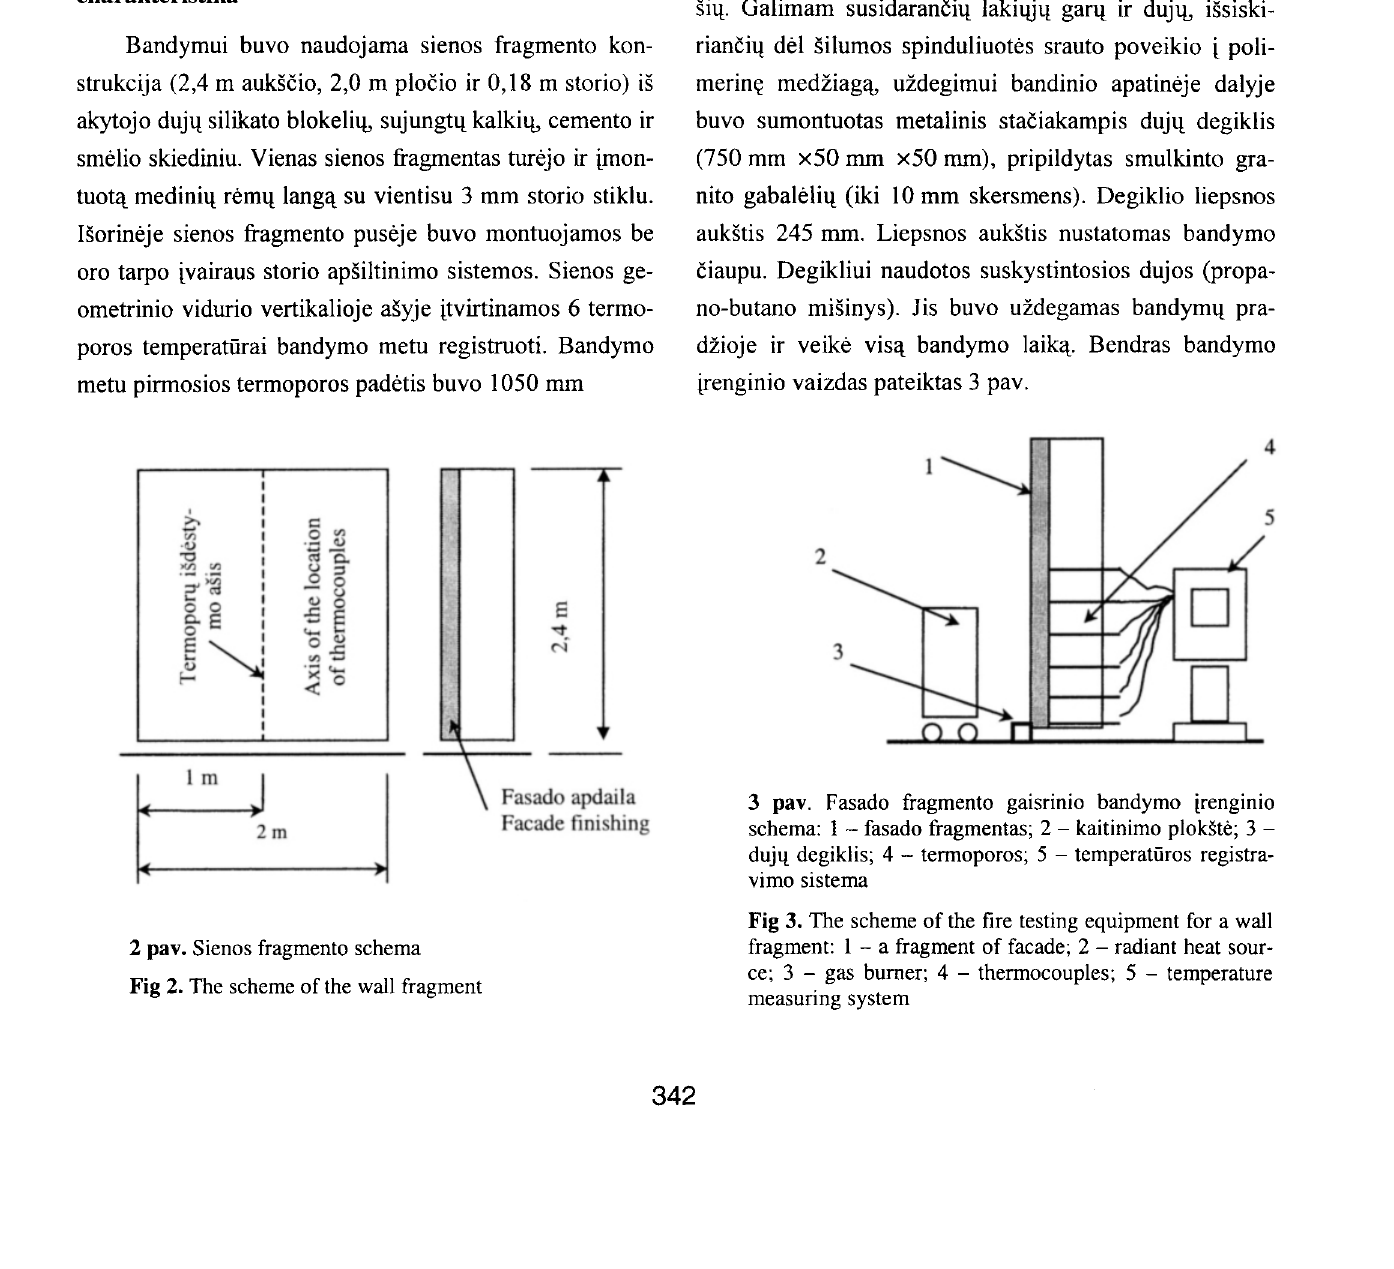
Fig 3. The scheme of the fire testing equipment for a wall fragment: 1 - a fragment of facade; 2 - radiant heat sour ce; 3 - gas burner; 4 - thermocouples; 5 - temperature measuring